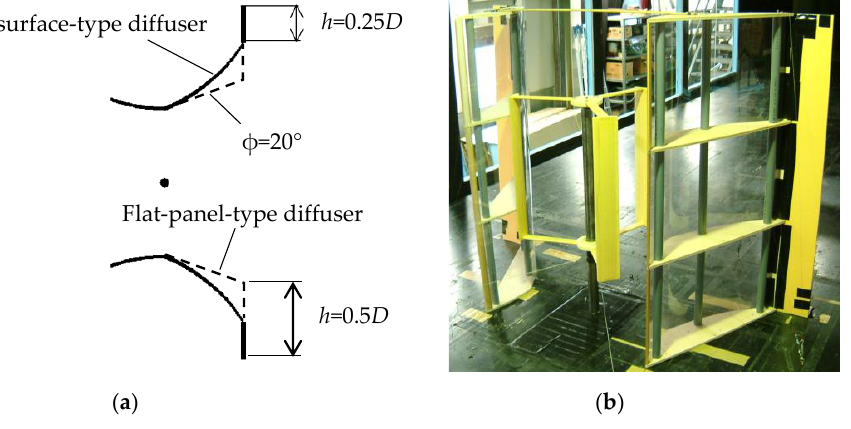
Figure 11. Configuration of the wind lens with a curved-surface-type diffuser: ( a ) plan view and ( b ) in situ photograph. Refer to Figure 2 for D . ( a ) Plan view; ( b ) Photograph.